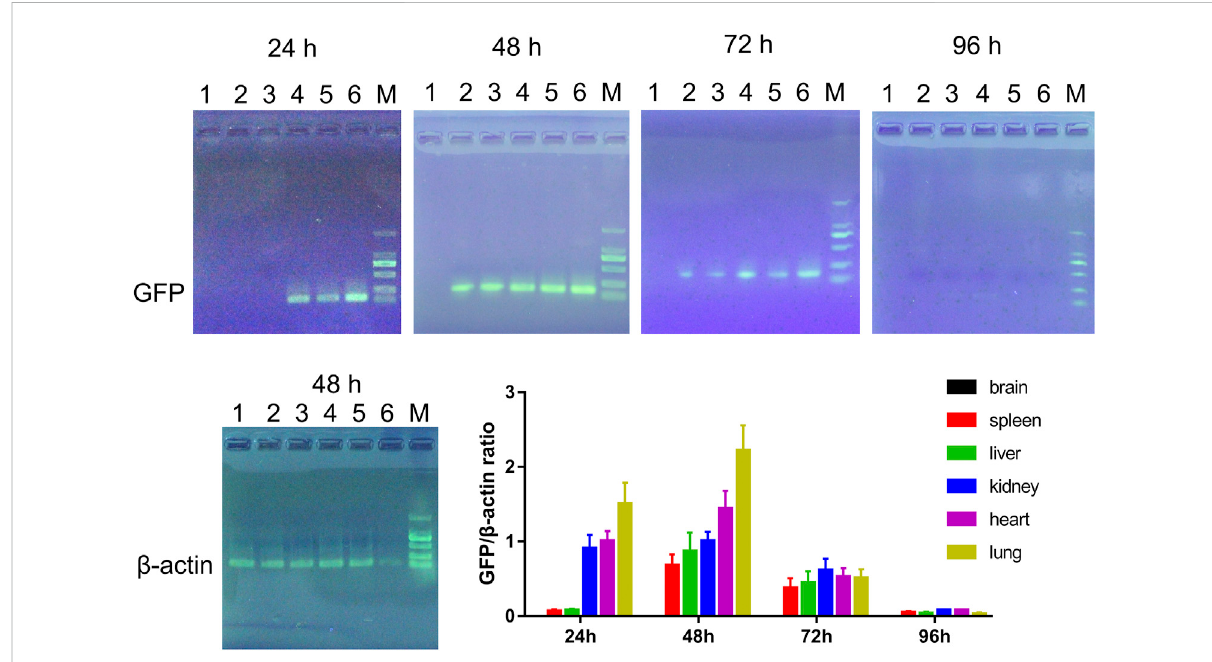
FIGURE 8 RepresentativeelectrophoresisimagesofRT-PCRproductsandthequantitativedata.1:Brain;2:Spleen;3:Liver;4:Kidney;5:Heart;6:Lung;M: DL2000 marker. n =